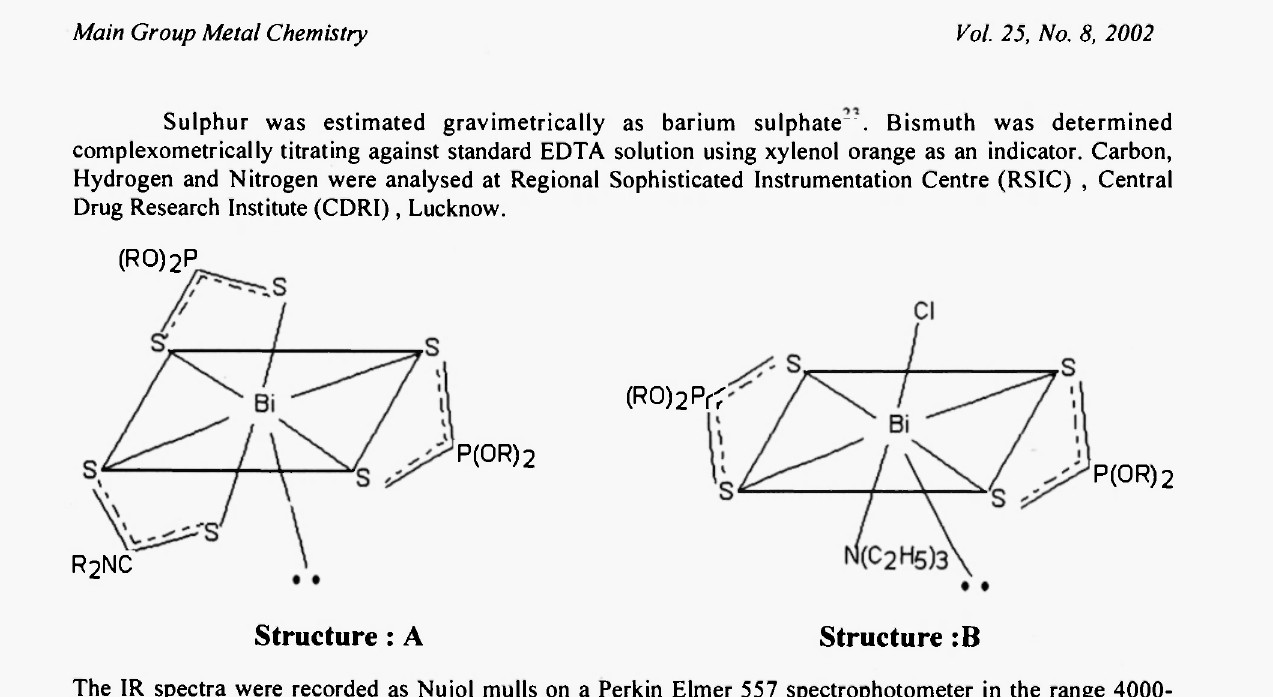
The IR spectra were recorded as Nujol mulls on a Perkin Elmer 557 spectrophotometer in the range 4000- 2000 cm' 1 . 'H, 13 C and 31 P NMR spectra were recorded in CDC1 3 solution on a Bruker DRX-300 spectrometer using TMS and H 3 P0 4 as internal standards, respectively. The mixed bismuth(III) bis(dialkyldithiophosphate) dialkyldithiocarbamate and complexes of chlorobismuth(III) bis(dialkyldithiophosphate) with triethylamine derivatives were synthesised by adopting the following methods (a) and (b) respectively. (a) of chlorobismuth(III)^ bis(diisopropyldithiophosphate) with sodium dimethyldithiocarbamate in 1:1 molar ratio A mixture of chlorobismuth(III) bis(diisopropyldithiophosphate) ( 0.99 g; 1.50 mmole) and sodium dimethyldithiocarbamate ( 0.27 g ; 1.50 mmole ) was refluxed in ~25 ml benzene for ~3 hours. Precipitated sodium chloride (0.10 g ) was separated by filtration. The solvent was removed from the filtrate to reduce the volume (-10 ml) and n-haxane ( ~10 ml) was added. The contents were than kept overnight in a refrigerator. The light yellow crystals thus obtained were dried and weighed. (Yield = 1.06 g; 95%, M.P. =98°C). Other derivatives were prepared by adopting a similar route. (b) Reaction of chlorobismuth(III) bis(diisopropyldithiophosphate) with triethylamine in 1:1 molar ratio In the solution of chlorobismuth(III) bis(diisopropyldithiophosphate) (1.79 g ; 2.67mmole) in dichloromethane (-15 ml ) solution triethylamine ( 0.27 g ; 2.67 mmole) in dichloromethane (-20 ml) was added dropwise . The contents were stirred for -4 hours at room temperature on removal of solvent yellow solid was obtained (Yield = 1.71 g ; 82% , M.P. = 105°C). Similarly, chlorobismuth(III) bis(diisobutyldithiophosphate)triethylamine was prepared by the reaction of chlorobismuth(III) bis(diisobutyldithiophosphate) (1.92 g; 2.67 mmole) and triethylamine (0.27 g ; 2.67 mmole) in dichloromethane (Yield = 1.86 g ; 84 % , M.P. =